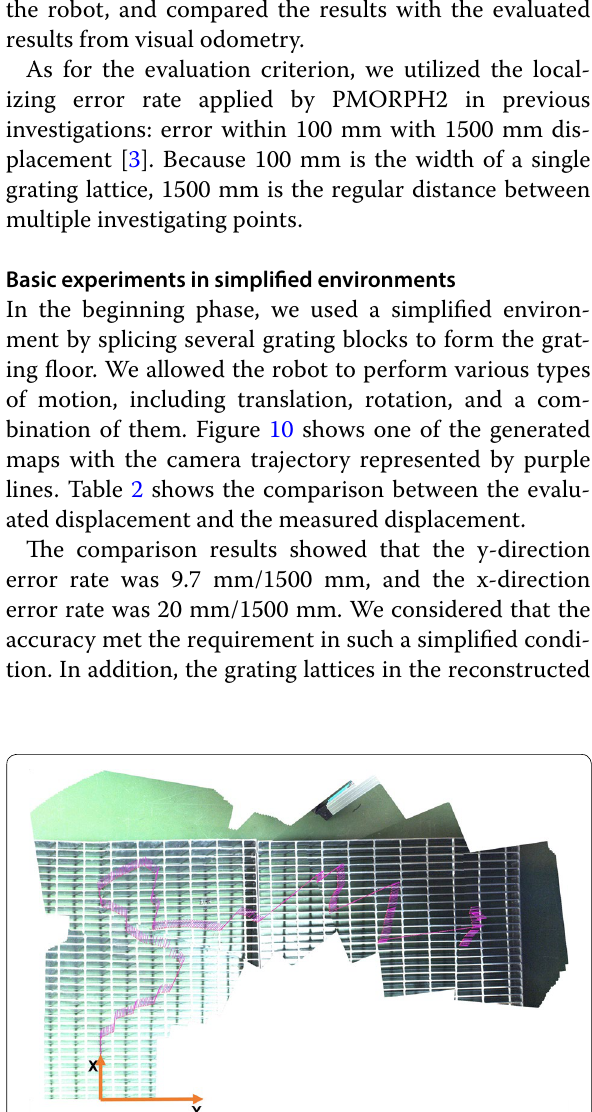
Table 1 Specification of RhinoUS Parameters